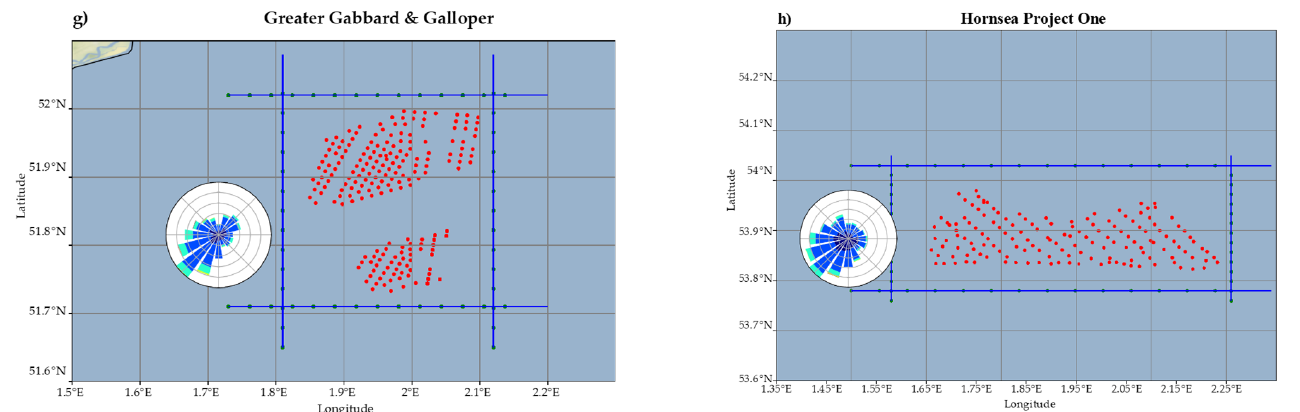
Figure 3. Selected OWFs and clusters: ( a ) Anholt, ( b ) Horns Rev 2 and 3, ( c ) Butendiek, ( d ) Amrumbank West, Nordesee Ost, and Meerwind Süd/Ost, ( e ) East Anglia One, ( f ) Global Tech 1, Albatros, and Hohe See, ( g ) Greater Gabbard and Galloper, and ( h ) Hornsea Project One. The blue lines are the transect lines around the OWFs and clusters, and the green points are the transect points and distributed uniformly along the transect lines. The red points are the positions of wind turbines, and the wind roses represent the wind direction taken from all available scenes at the transect point P7 at the west transect line.